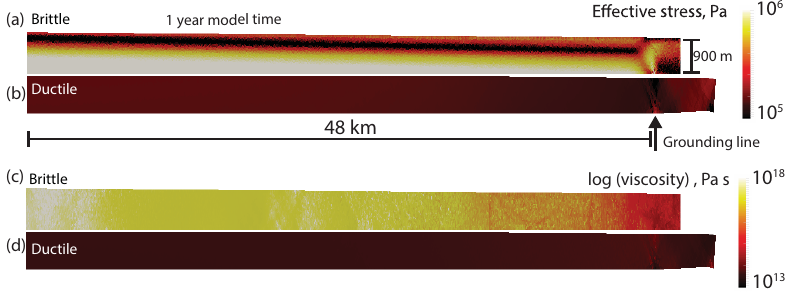
Figure 5. Effective stresses in (a) purely brittle and (b) purely ductile ice for wedge experiments after 1 year of model time. The left nodes vary freely in the vertical and are fixed to 0 in the horizontal, and the basal boundary is free-slip. There is an order-of-magnitude difference in stress. Again, brittle ice experiences a small process zone of high stress immediately at the grounding line (black arrow) where there is a transition from freely slipping ice to a buoyancy stress condition with a 1m diurnal tidal forcing, and the forces due to bending are high. Ductile ice also experiences an increase in stress at this location, although the transition is not as sharp. Most notably, flow in brittle ice is negligible compared to ductile ice after 1 year, owing to the very large (as much as 5 orders of magnitude) difference in viscosity between the (c) brittle and (d) ductile